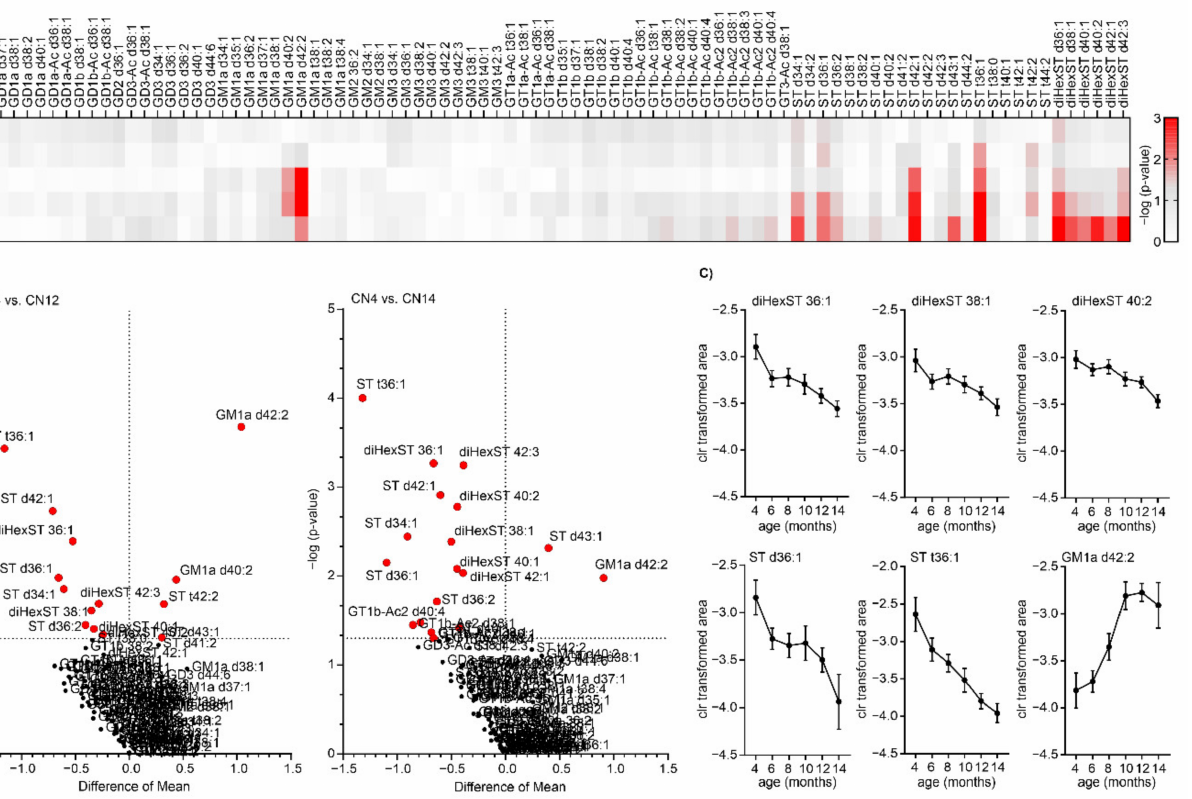
Figure 3. Altered levels of several ganglioside and ST species in the aging process. ( A ) Heatmap showing results from significance testing as -log10 ( p -value). ( B ) Volcano plots showing the results from the statistical analysis of GSL profiles in 12-month-old and 14-month-old control animals compared with control animals (4-month-old). The dashed line represents a p -value threshold of 0.05. ( C ) Confidence intervals for selected GSs and STs that are significantly altered in the brainstem of rats during aging. Data are shown as Mean ± SEM (standard error of